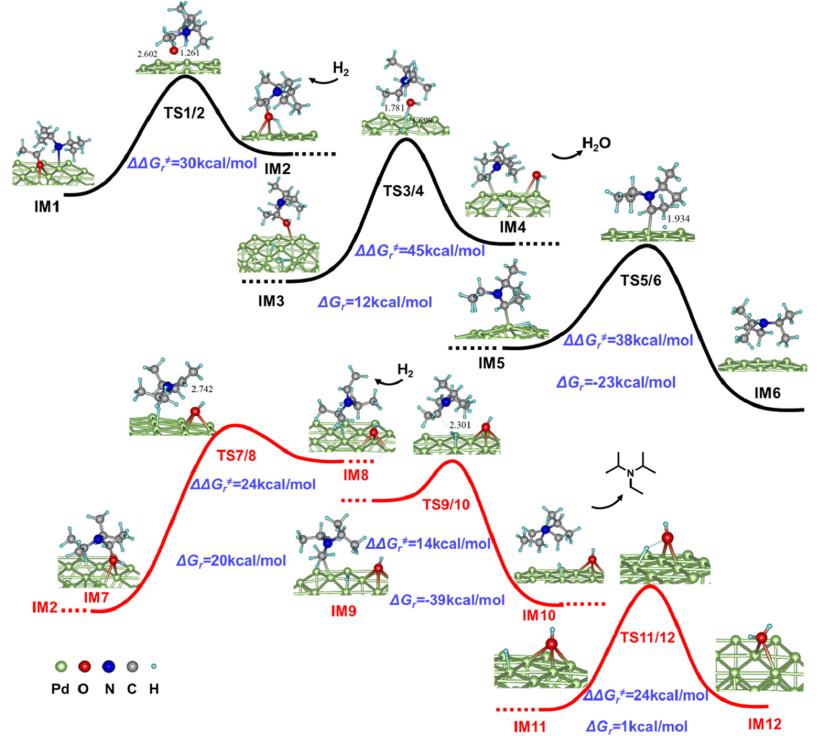
Figure 6. Simplified PES and selected structural information of alternative pathways for the gener- ation of N,N-Diisopropylethylamine mediated by the Pd(111) plane via hydrogenolysis (black) and imine (red) mechanisms.